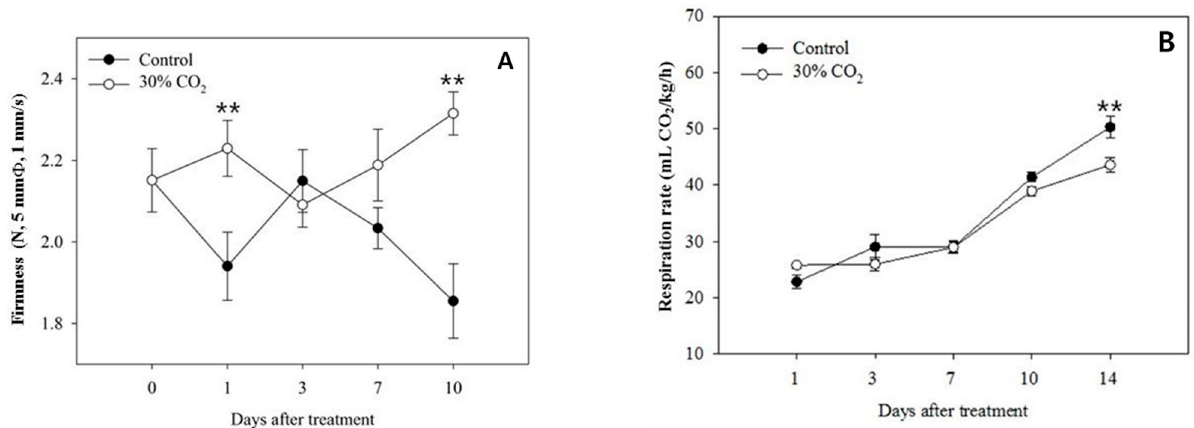
Figure 1. Changes in fruit firmness ( A ) and respiration rate ( B ) of strawberry fruits (Fragaria × ananassa Duch. ‘Seolhyang’) treated with 30% CO 2 for 3 h, as well as control fruits. The data are expressed as the means ± standard errors of 15 replications. ** p < 0.01.